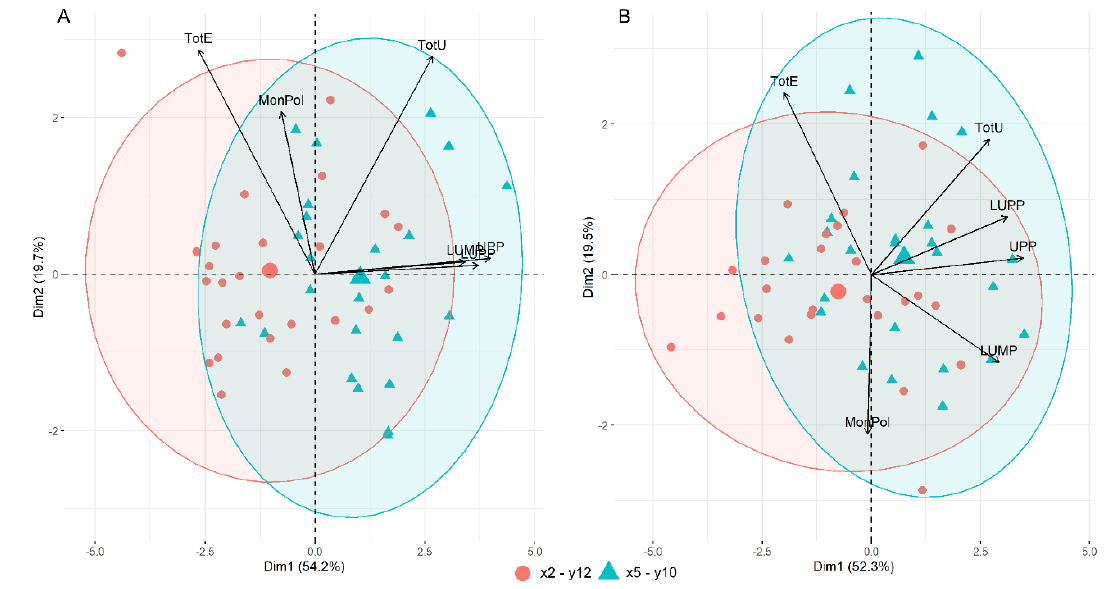
Figure 6. Principal component analysis of winter wheat gluten protein parameters in sustainable fertilization trials in 2018 ( A ) and 2019 ( B ).